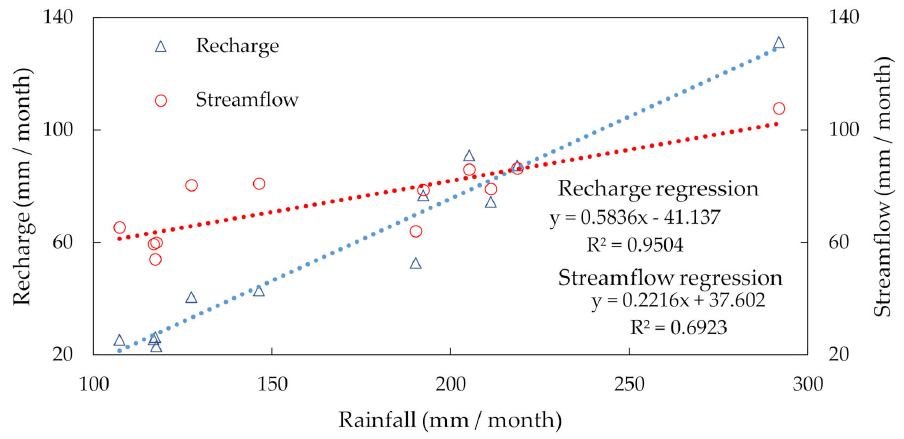
Figure 6. The relationship between the monthly averages (2002–2014) of water balance components (mm) of the Heeia